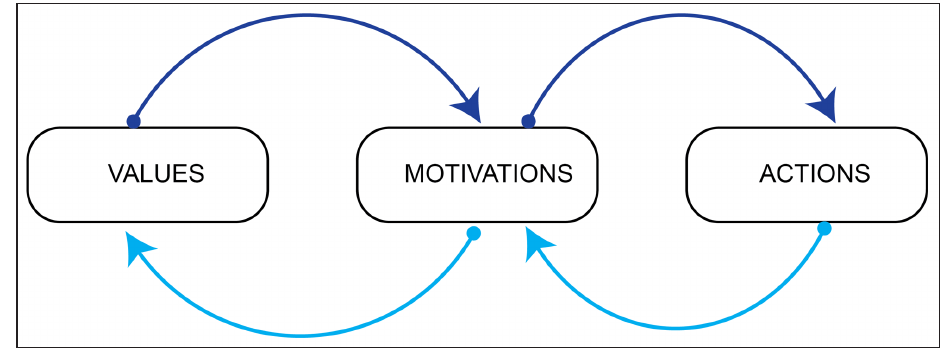
Figure 3: Feedback relationship between values, motivations, and actions (adapted from Palacin-Silva 2018, p. 4 and Knowles 2013, p.